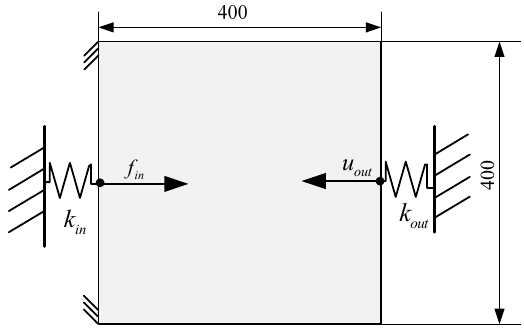
Figure 4. The design domain of a compliant inverter mechanism. Table 1. Design parameters for the inverter mechanism.